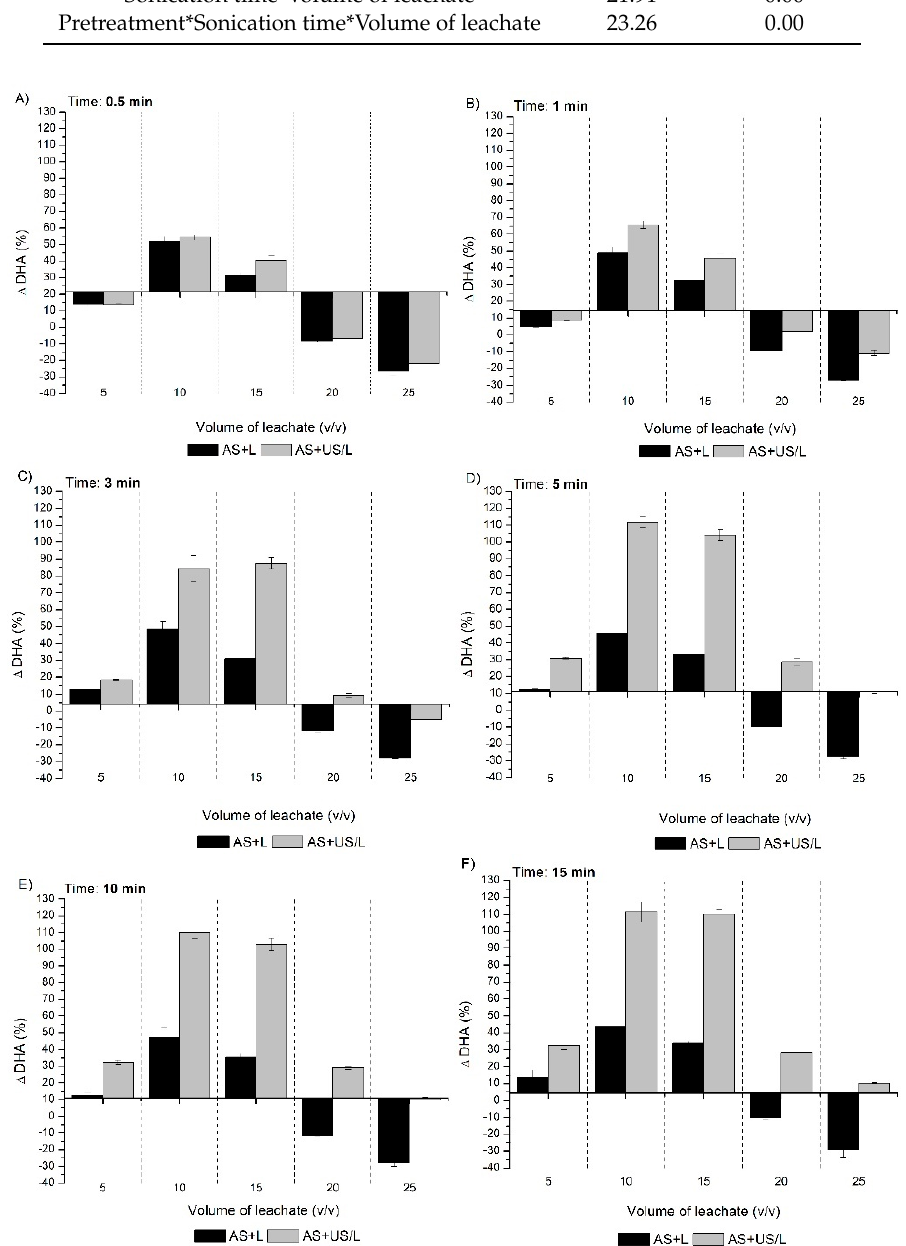
Figure 6. Variation of Δ DHA activity at different volumetric ratios of leachate in the mixture and sonication time of: ( A ) 0.5 min; ( B ) 1 min; ( C ) 3 min; ( D ) 5 min; ( E ) 10 min; ( F ) 15 min (vertical bars denote +/ − standard errors; AS + L—Activated sludge + leachate without pretreatment; AS + US/L—Activated sludge + leachate with